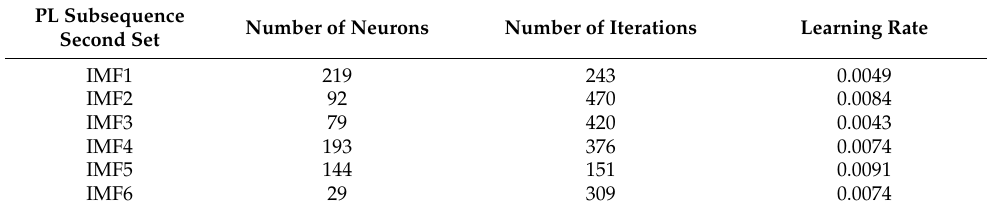
Table 8. Results of hyperparameters optimized by PSO based on second set